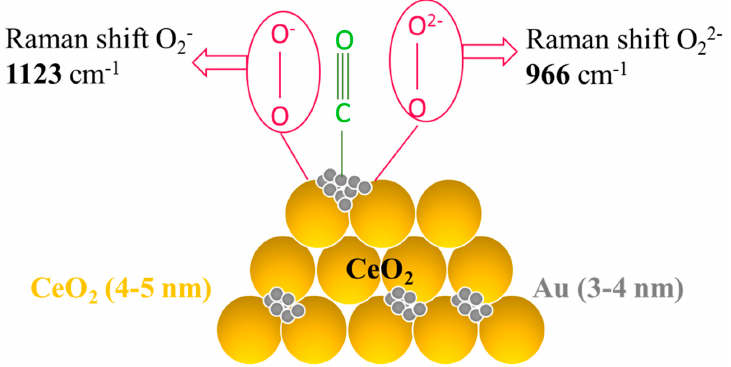
Figure 5. Schematic representation of CO oxidation catalyzed by gold on nanocrystalline reflecting the role of oxygen reactive species. (CeO 2 yellow, Au grey. The position of the characteristic Raman bands of superoxide (O 2 − , 1123 cm − 1 ) and peroxide (O 22 − , 966 cm − 1 ) species are shown). Adapted from Guzman et al. [170].